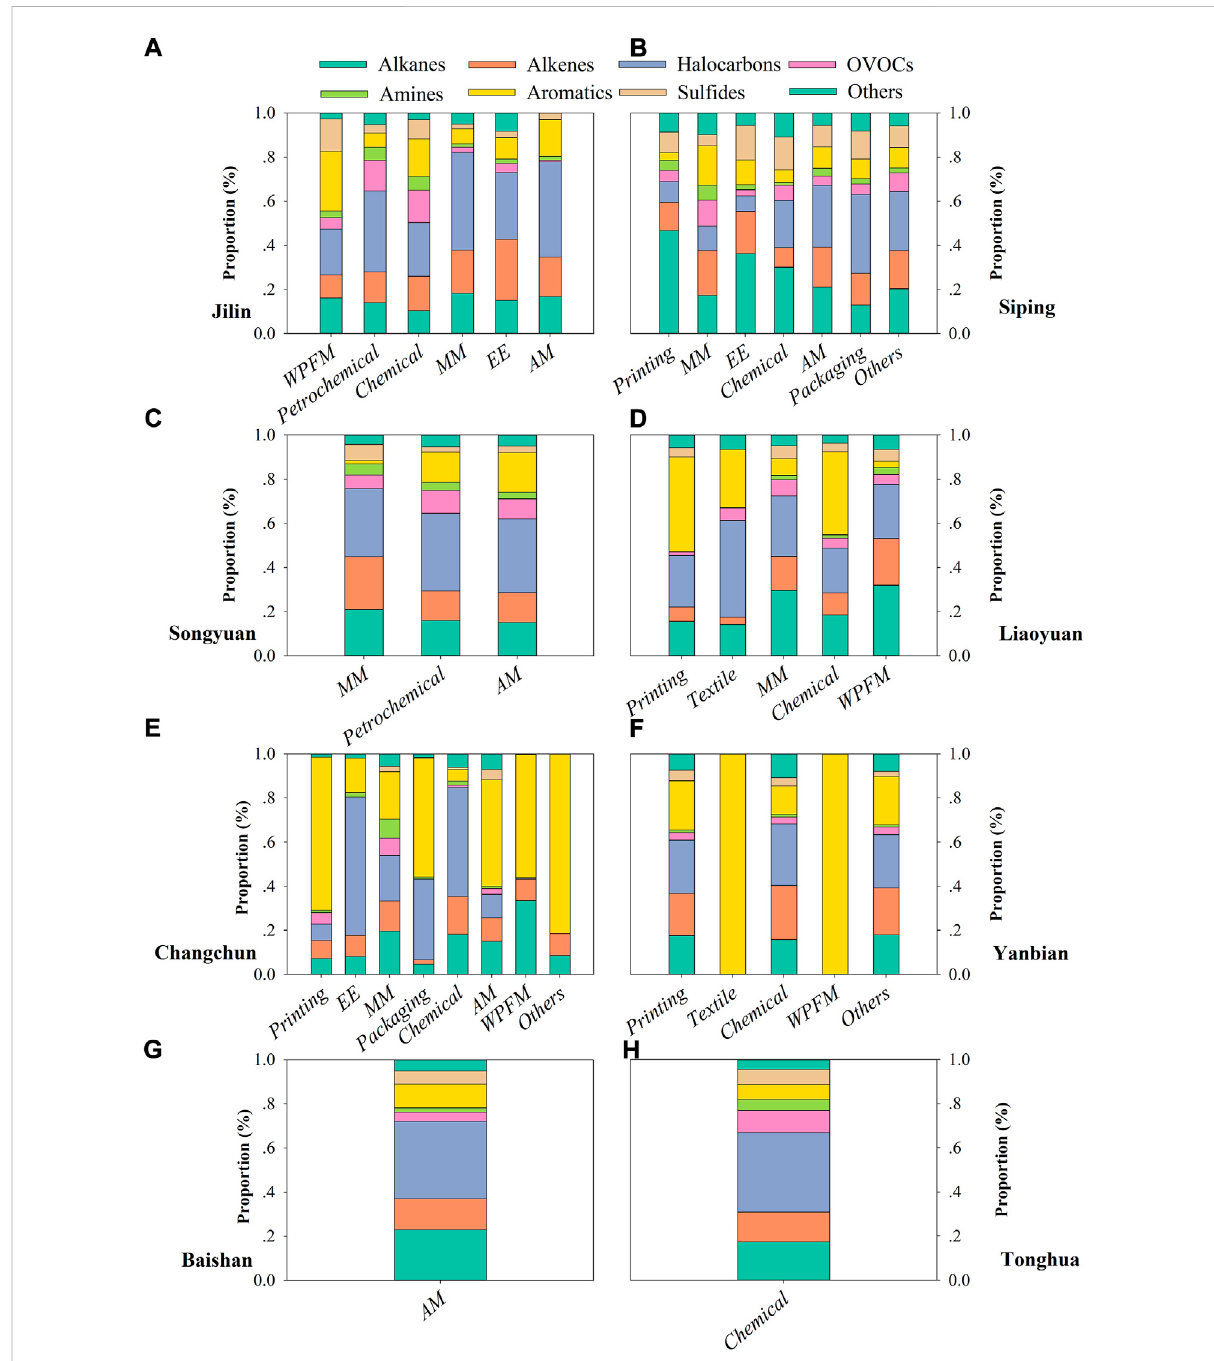
FIGURE 3 Types of pollutants discharged by various industries. EE, Electronic and Electrical; MM, Machinery Manufacturing; AM, Automobile Manufacturing; WPFM, Wood Processing and Furniture